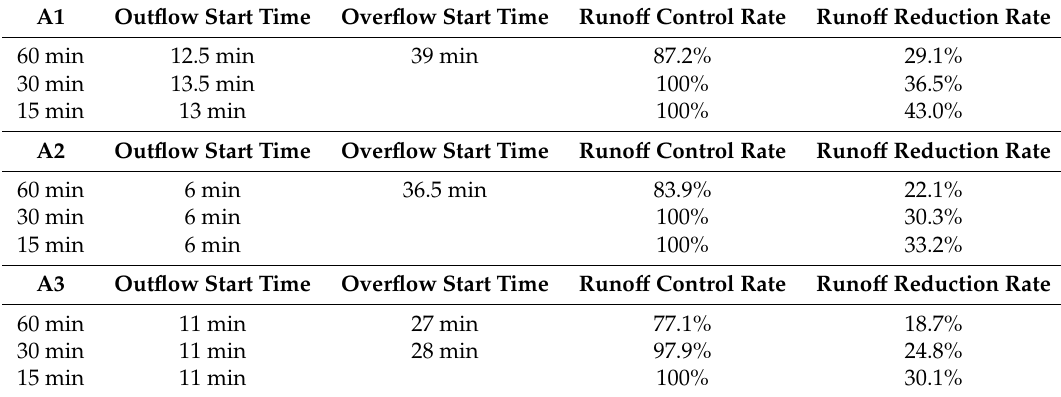
Table 3. Runo ff control e ff ects of each bioretention units under di ff erent rainfall